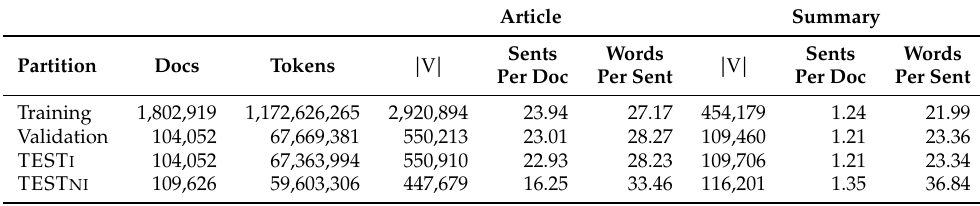
Table 4. Statistics of partitions for Spanish